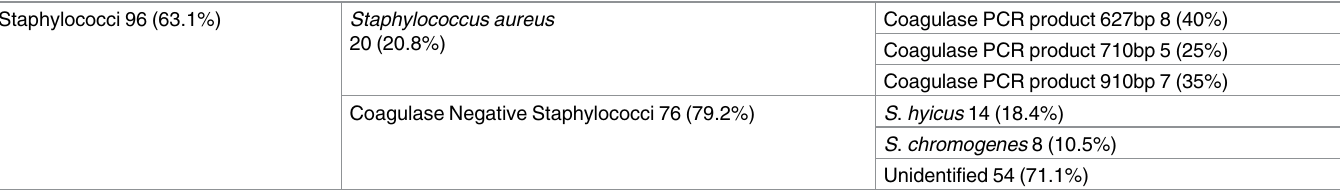
Table 3. Frequencies of different Staphylococci isolated from udder secretions of 157 dry cows in India. Staphylococci 96